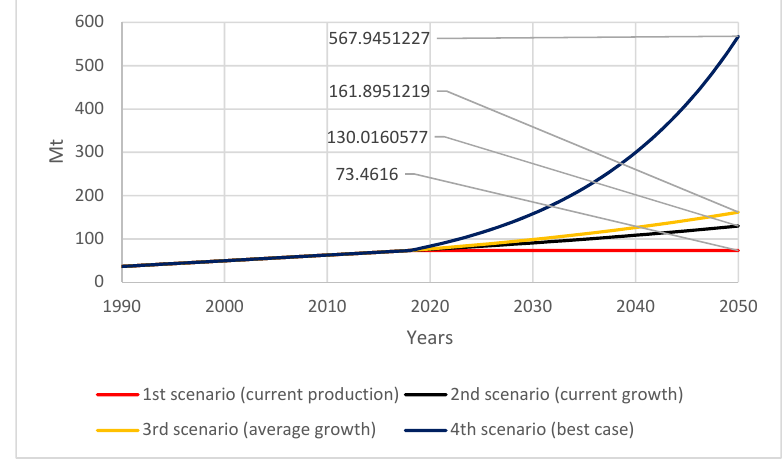
Figure 8. The system dynamics model of hydrogen demand.